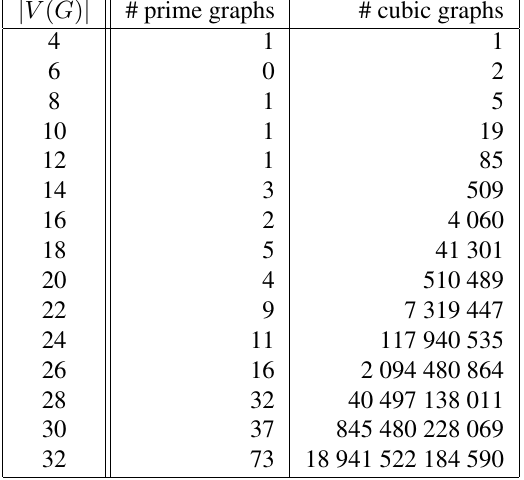
Table 1: Number of prime graphs vs. number of cubic